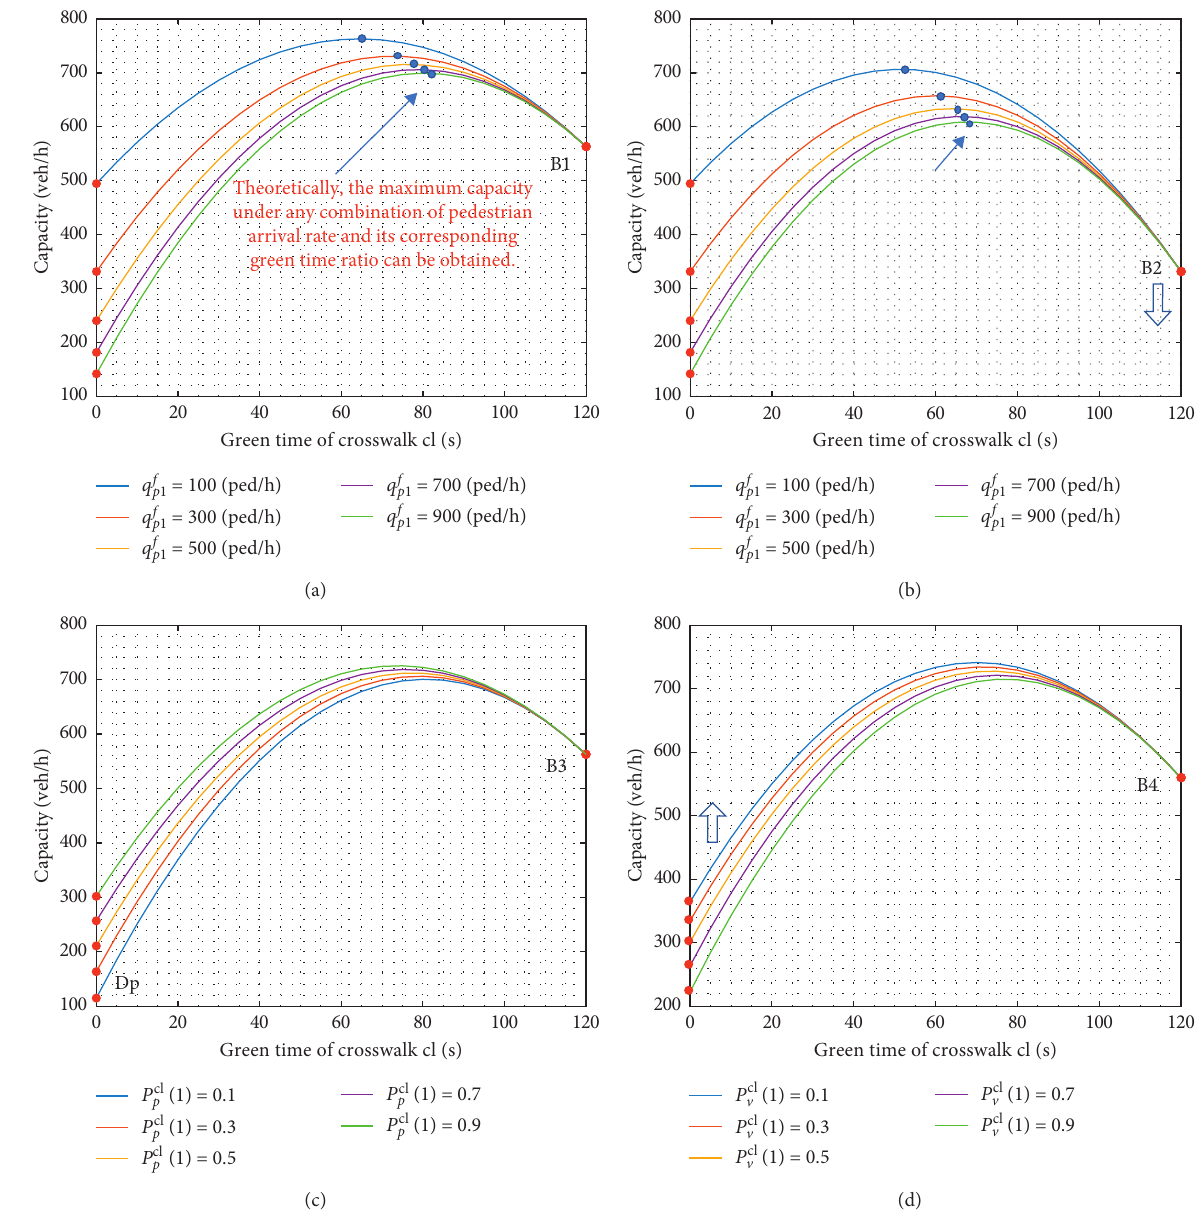
Figure 5: The sensitivity of capacity to green time radio. (a) q f � 700 ( ped/h ) (d) q f p 2